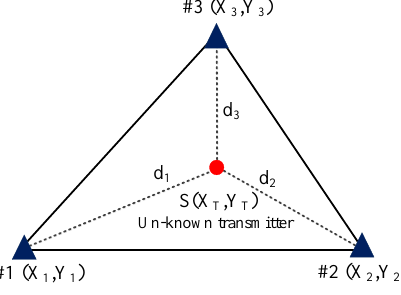
Figure A1. The demonstrated diagram of solving the location by using the previous computing